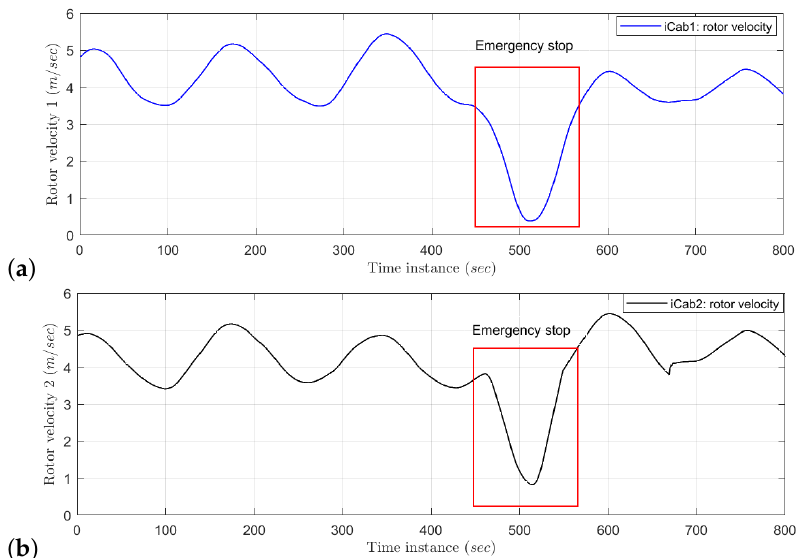
Figure 7. Test data: Emergency stop. ( a ) iCab1 rotor velocity, ( b ) iCab2 rotor velocity. A total of four data samples are collected at every second.